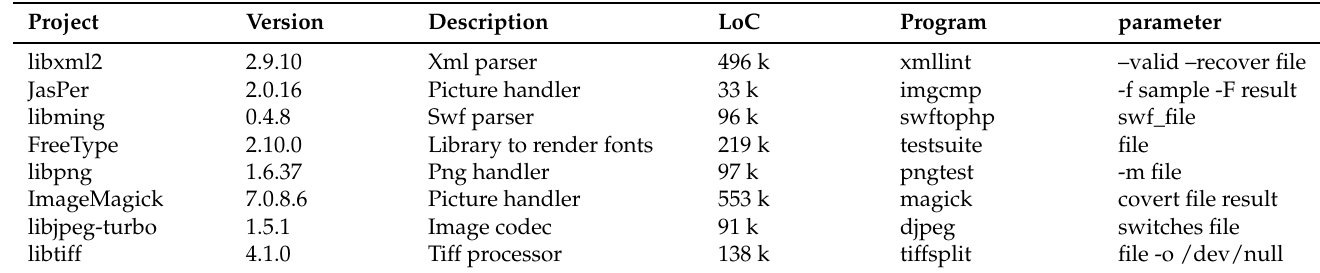
Table 3. The information about the